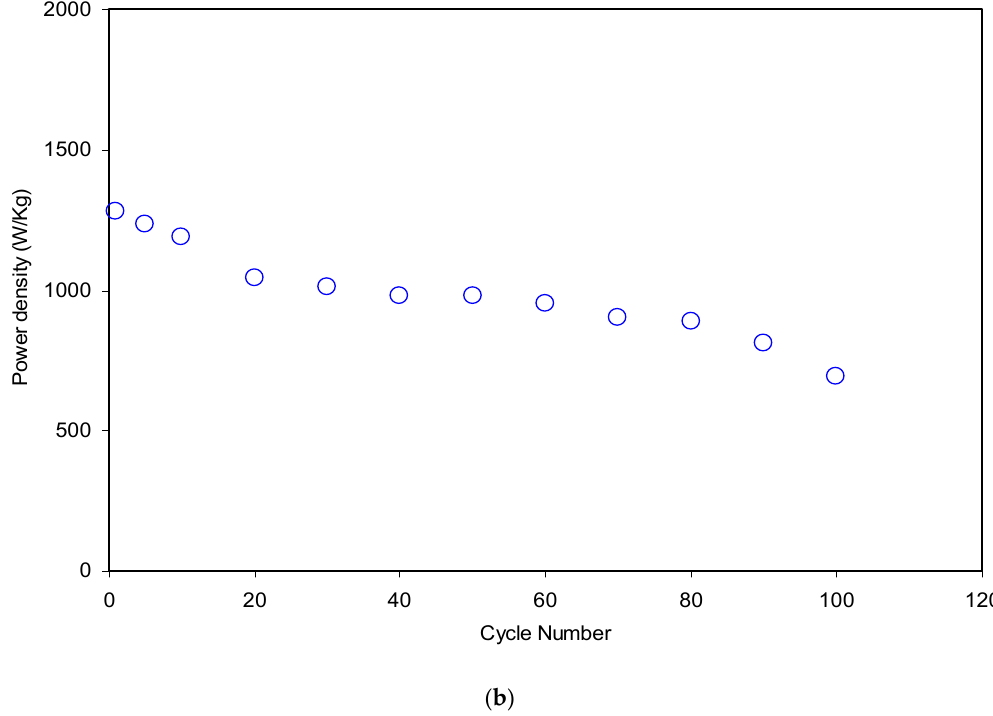
Figure 14. ( a ) Energy density of the assembled EDLC for 100 cycles and ( b ) power density of the assembled EDLC for 100 cycles.